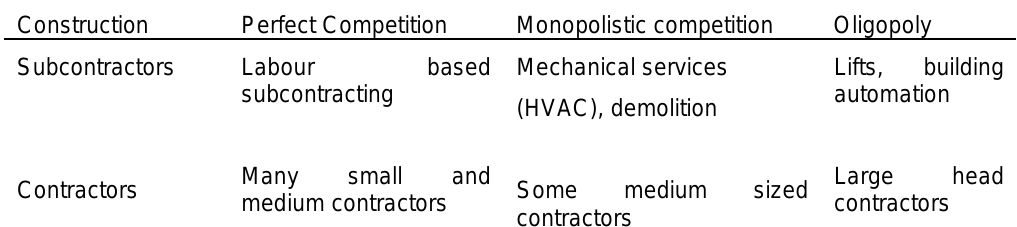
Table 1. Construction Industry Firms by Market Type